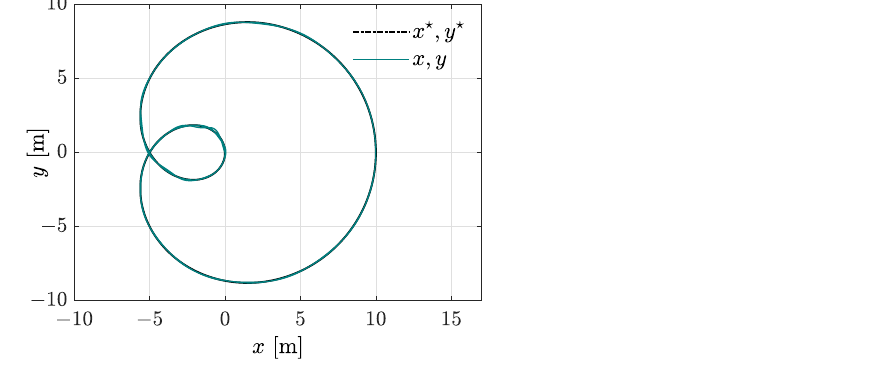
Figure 17. Path following on the horizontal plane describing a geometric Lissajous curve.